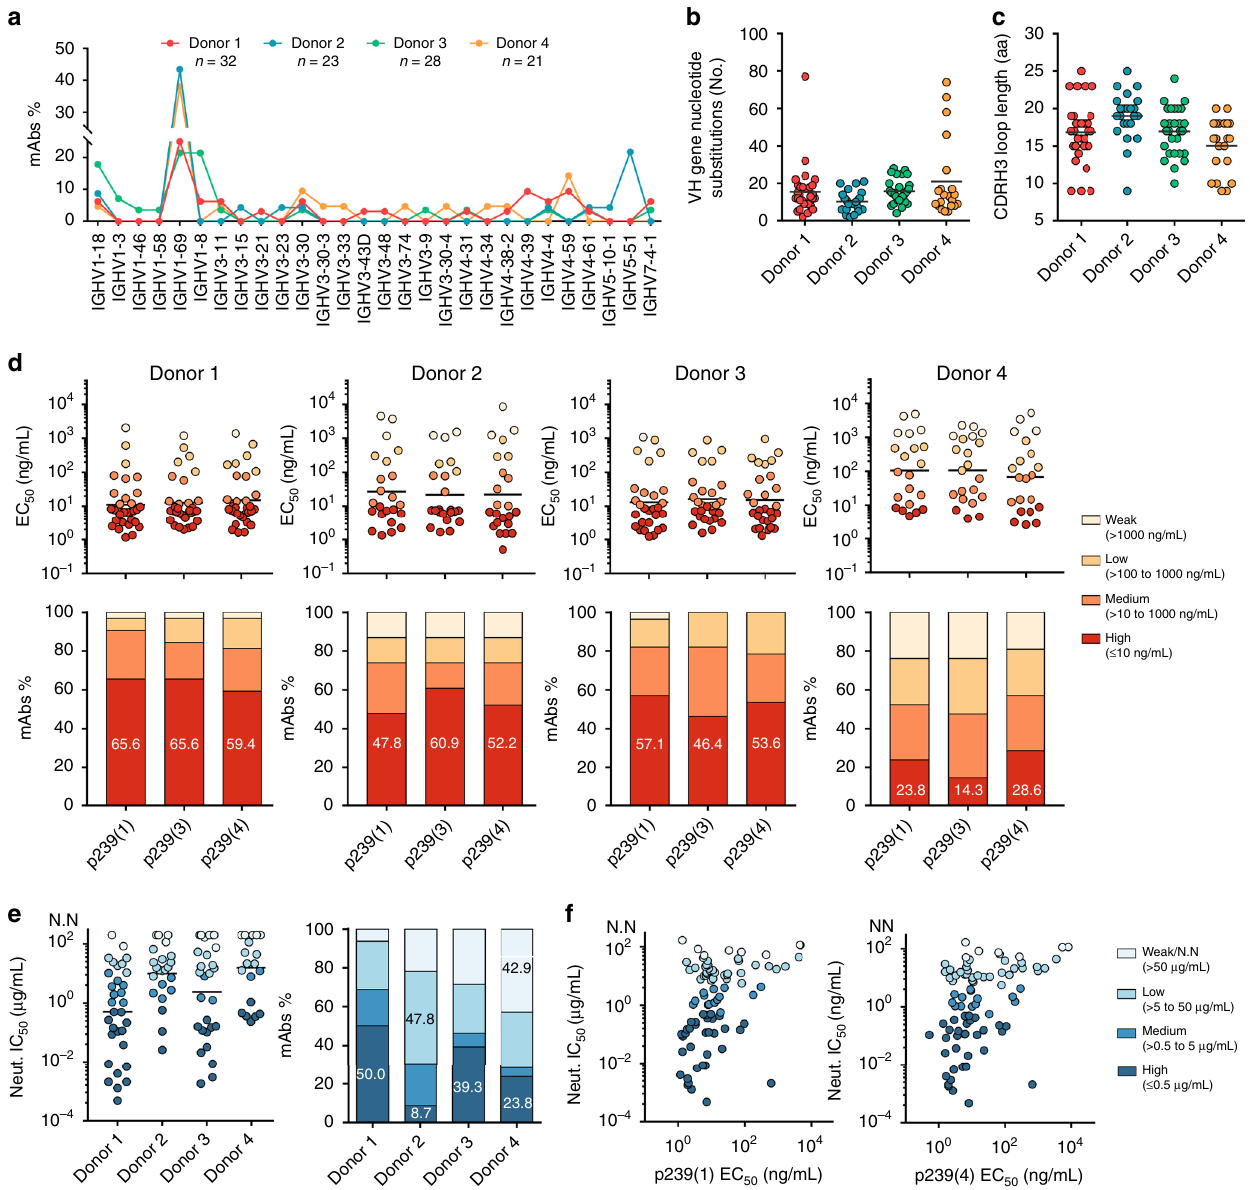
Fig. 2 Systems analysis of HEV vaccine-induced p239(1)-speci fi c mAbs. a Distribution of heavy-chain variable (VH) germline genes. Donors 1, 2, 3, and 4 are indicated by red, cyan, green, and orange, respectively. b Distribution of nucleotide mutations in the VH gene. Black bars indicate the mean value. c Distribution of heavy-chain complementarity-determining region 3 (CDRH3) lengths (amino acids, aa). Black bars indicate the mean value. d Antibody- binding activity (EC 50 ) measured for the p239 proteins of three genotypes ( 1 , 3 , and 4 ) in four ranges (upper panel), and percentage of mAbs with the indicated EC 50 range (lower panel). Black bars indicate the geometric mean value. e Antibody-neutralizing activity (IC 50 ) in four ranges (left) and percentage of mAbs with the indicated IC 50 range (right). N.N. denotes non-neutralizing. Black bars indicate the geometric mean value. f Correlation of neutralizing activity (IC 50 ) and binding activity (EC 50 ) measured for p239(1) (left) and p239(4) (right). IC 50 is divided into four ranges as in ( e ). Each colored circle in ( b ) to ( f ) represents a mAb. The number of mAbs shown in ( b ) to ( e ) is 32 for donor 1, 23 for donor 2, 28 for donor 3, and 21 for donor 4, respectively. Vaccine-speci fi c but non-neutralizing mAbs are excluded in ( f ) as their IC 50 values cannot be accurately determined. A total of 88 mAbs are shown in ( f ). Spearman rank-correlation analysis was used to analyze the relationship between p239 binding and HEV neutralization (for p239(1): P < 0.0001, r = 0.409; for p239(4): P < 0.0001, r = 0.424) in ( f ). Source data are provided in the Source Data fi